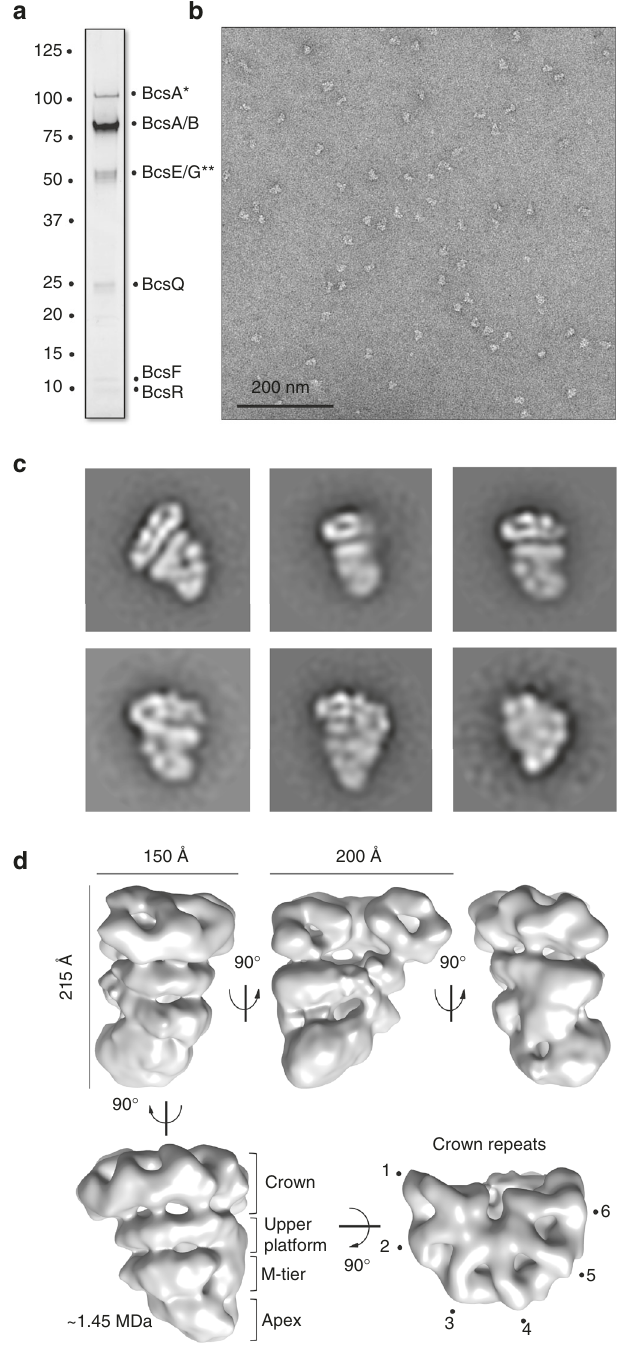
Fig. 2 Electron microscopy analysis of the Bcs macrocomplex. a Puri fi cation of the Bcs macrocomplex expressed in the overexpression E . coli 1094 bcsA HA-FLAG 2K7 strain. SDS-PAGE of the af fi nity-gradient and density gradient-puri fi ed Bcs macrocomplex stained with Coomassie blue. Band labels are as identi fi ed by mass-spectrometry and